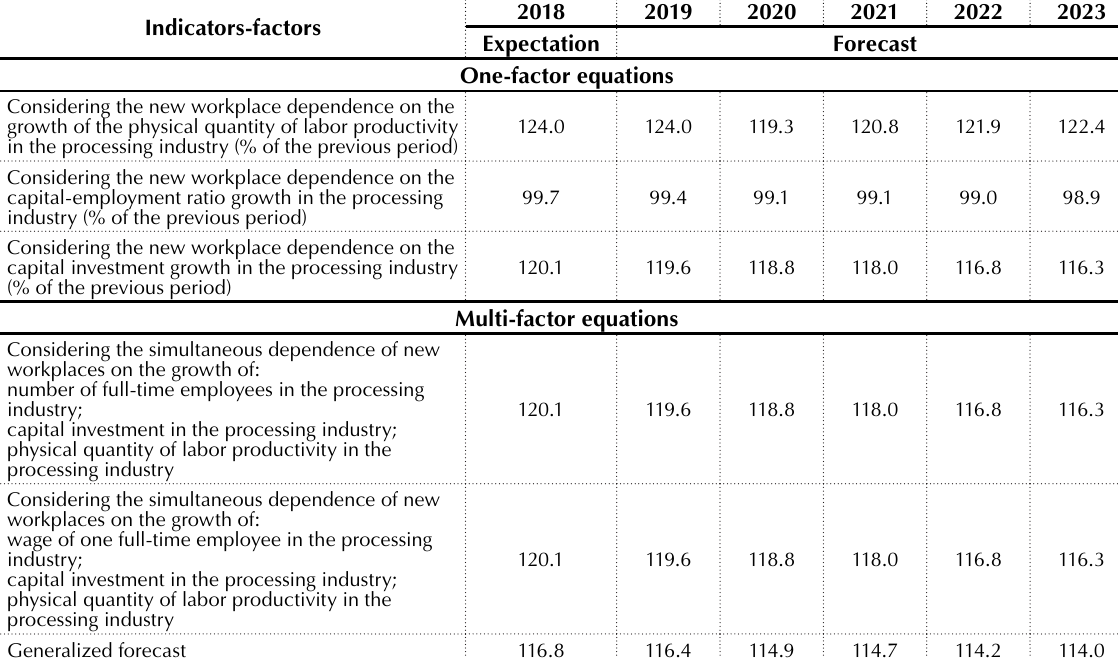
Table 7. Forecast of growth (slowdown) rate of new workplaces in the processing industry for 2019–2023 Source: Calculated by the authors based on the model